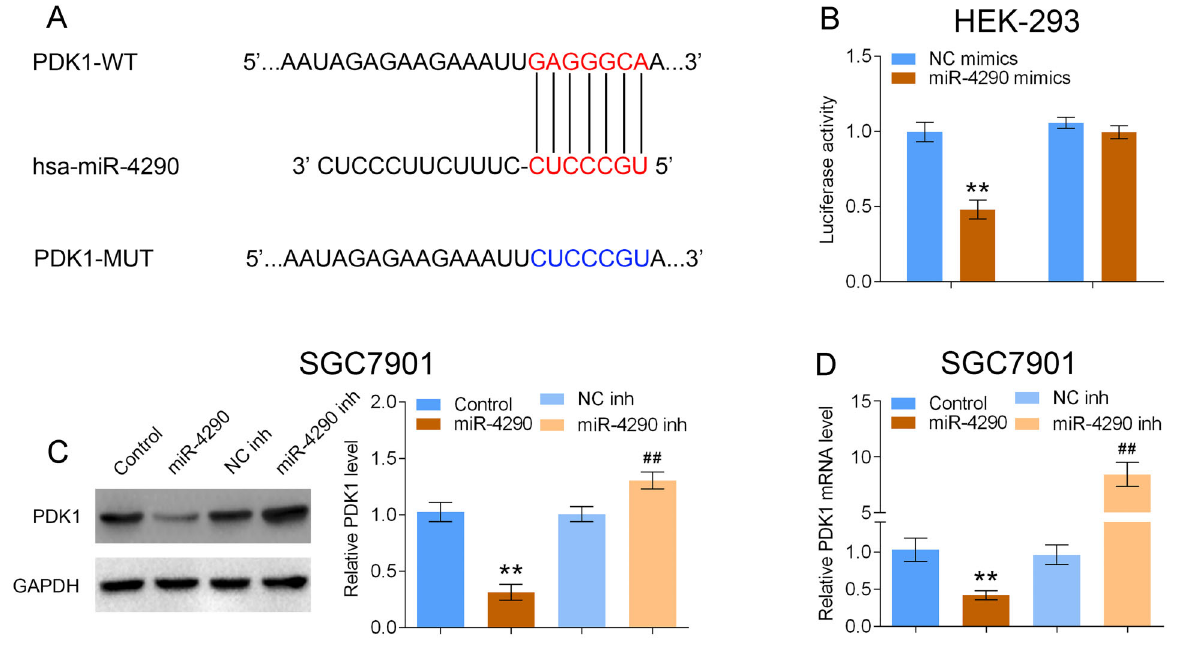
Figure 3. PDK1 was a direct target of miR-4290 in HEK-293 cells. A , The putative binding sites between miR-4290 and PDK1 and the mutated binding sites. WT, wide type; MUT, mutated type. B , The luciferase gene reporter assay was used to evaluate the relationship between miR-4290 and PDK1 after cell transfection with Negative Control (NC) mimics or miR-4290 mimics (n=3, **P o 0.01). C , Western blotting analysis on the protein expression level of PDK1 after HEK-293 cells were transfected with Control, miR-4290, NC inh, or miR-4290 inh, and D , PDK1 RNA level (n=3, **P o 0.05, compared with Control; ## P o 0.05, compared with NC inh group). Data are reported as means ± SD